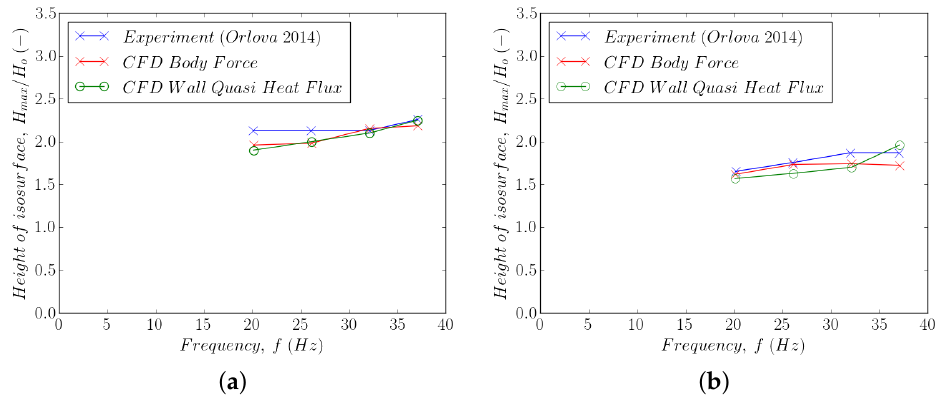
Figure 6. Validation of wall-normal vibration model. ( a ) H 0 = 20mm, ( b ) H 0 =